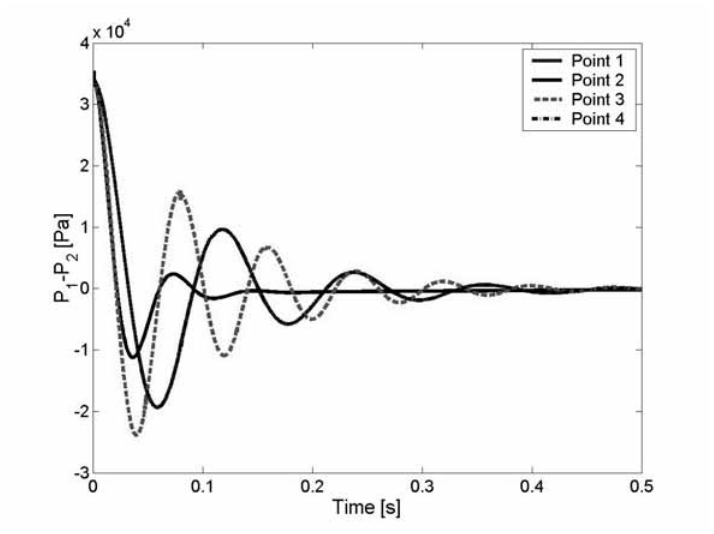
Fig. 35. Chamber pressure difference transient